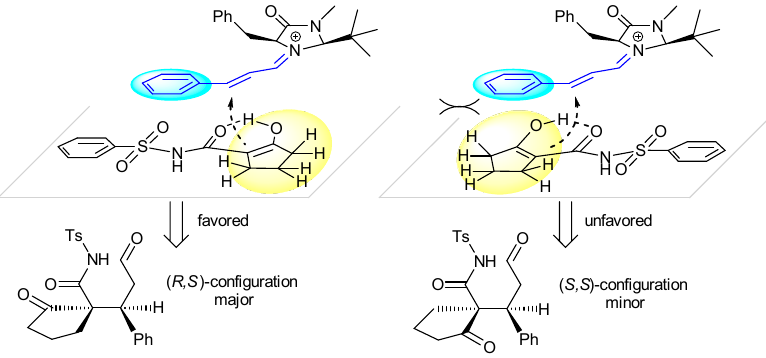
Figure 2. Proposed catalytic models to explain stereochemistry.